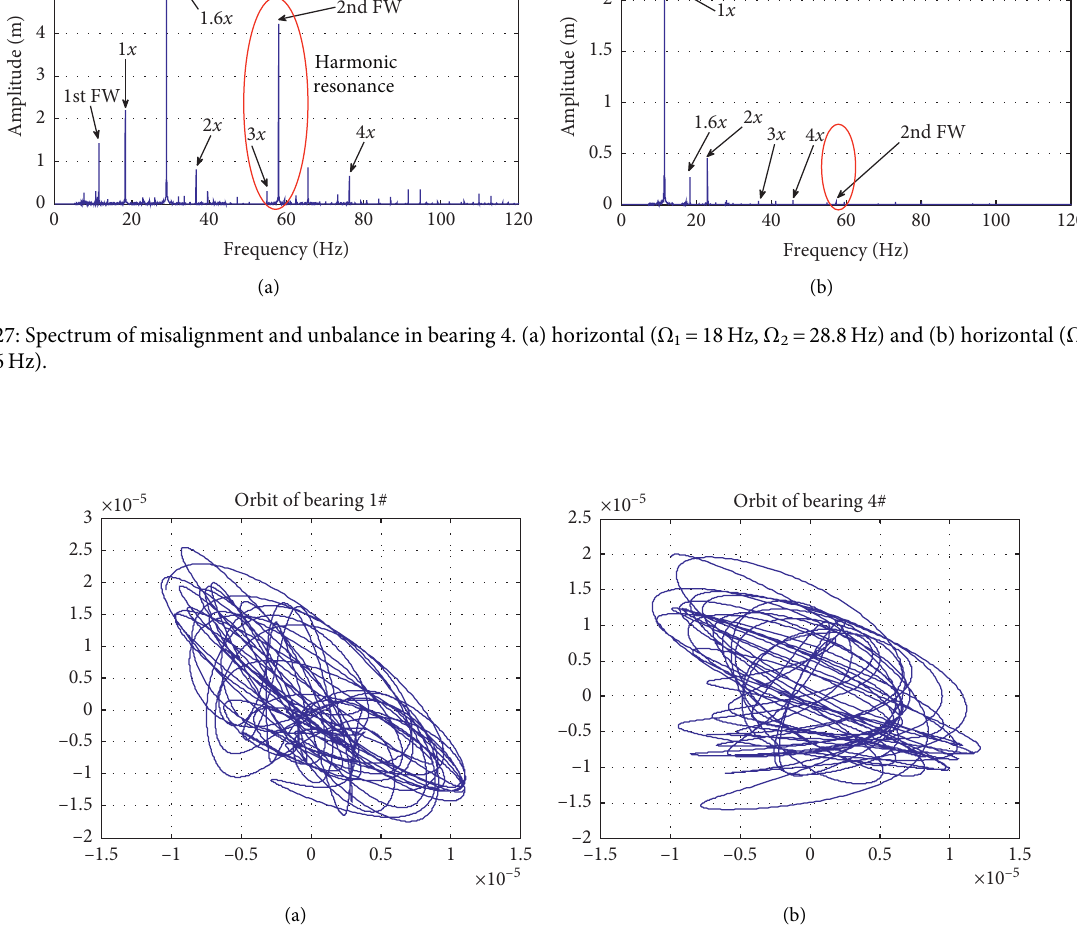
� 21.6Hz, Ω � 34.6Hz): (a) bearing 1 and (b) bearing 4. 1 2